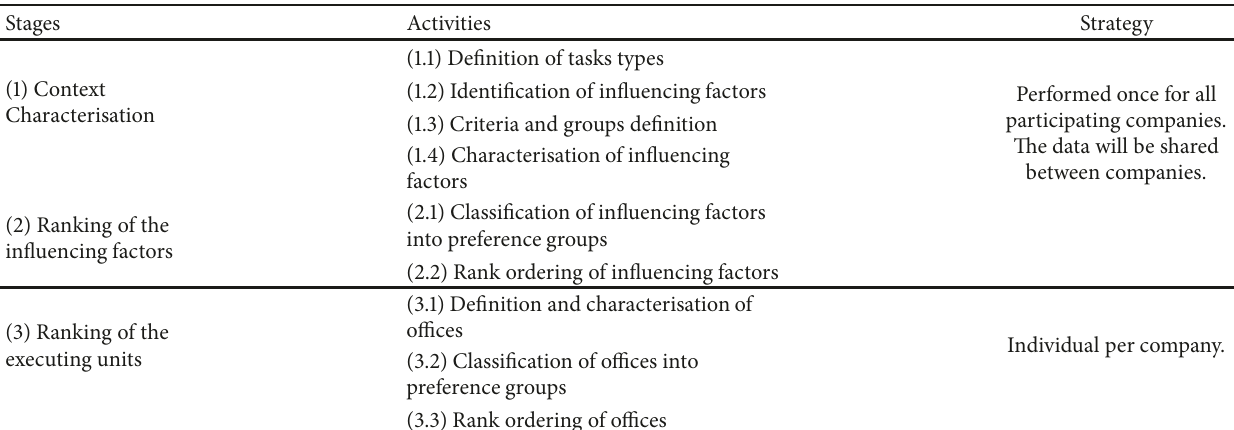
Figure 2: Geographic distribution of the companies’ offices. Table 5: Strategy for application of the